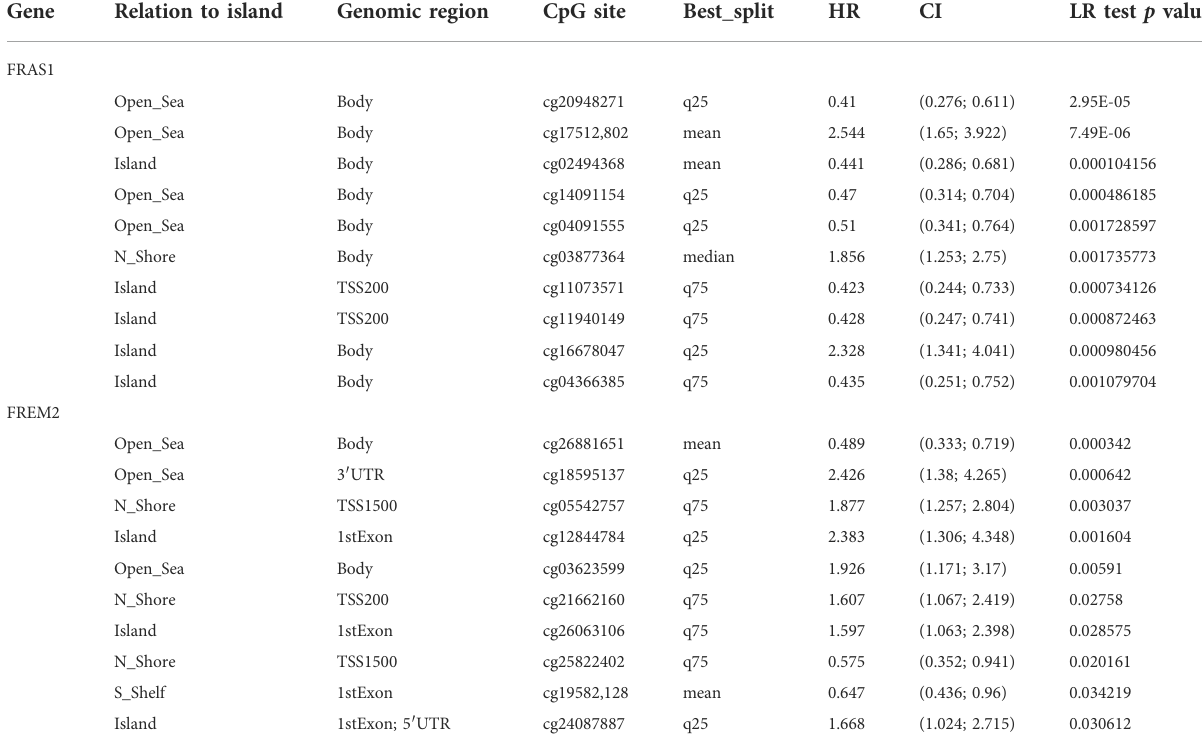
TABLE 2 The prognostic value of single CpG of FRAS1 and FREM2 in KIRC by MethSurv ( p <